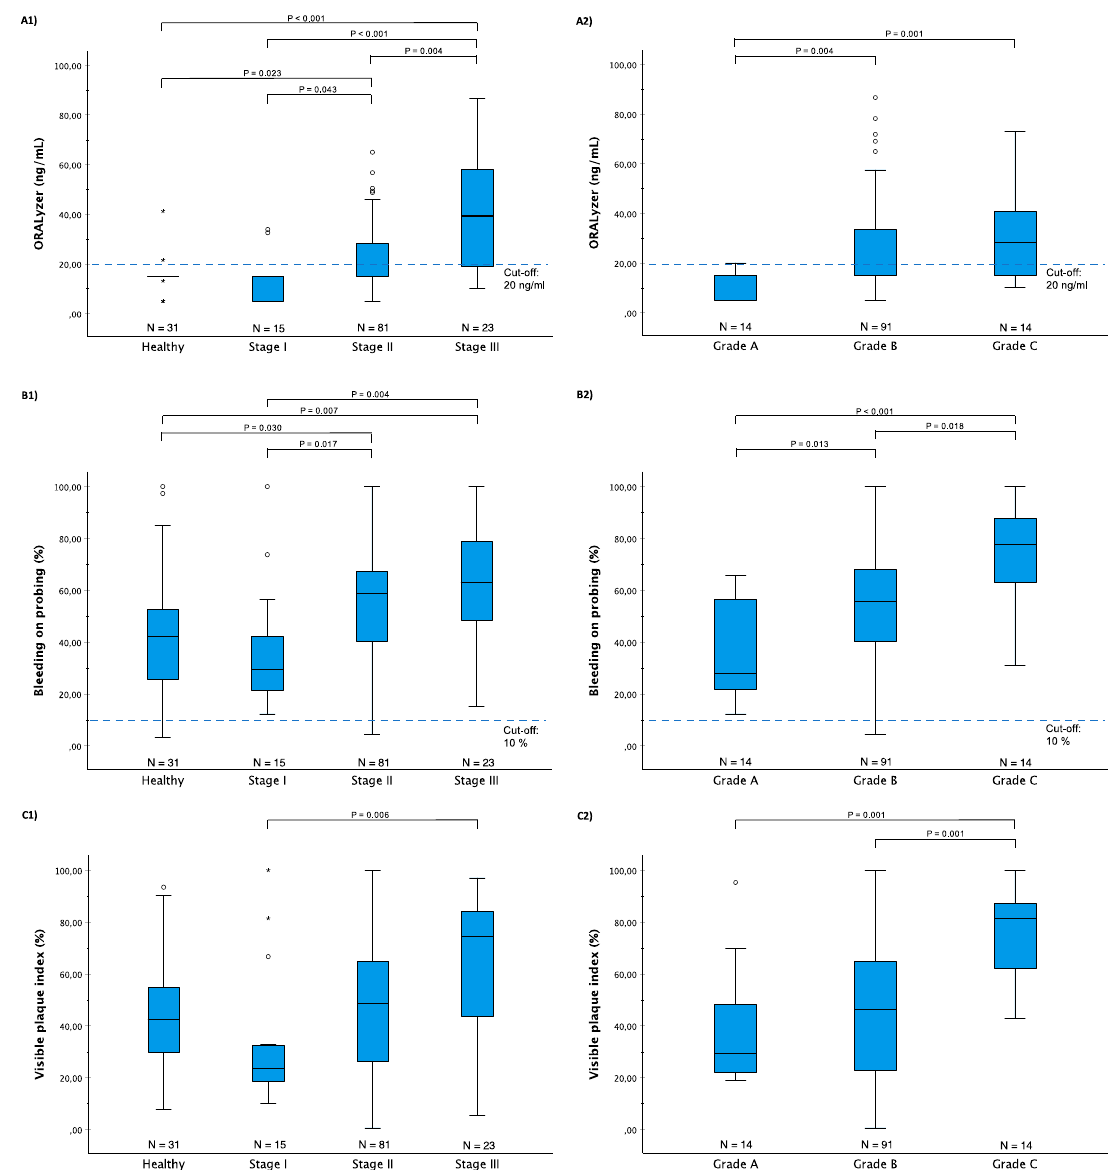
Figure 1. ( A ) ORALyzer (ng/mL), ( B ) bleeding on probing (BOP) (%) and ( C ) visual plaque index (VPI) (%) vs. (1) periodontitis stages and (2) periodontitis grades (N = 150) described by Tonetti et al. [1]. Kruskal–Wallis test was significant ( p < 0.01) for all the three variables in both cases. All significant ( p < 0.05) pairwise post hoc comparisons (Dunn–Bonferroni test) are marked in the plots. The box-and-whiskers plots illustrate the median, quartiles, and extreme values. Previously validated cut-off of 20 ng/mL for aMMP-8 assays [10] and cut-off of 10% for BOP [1,49] marked in the figure.